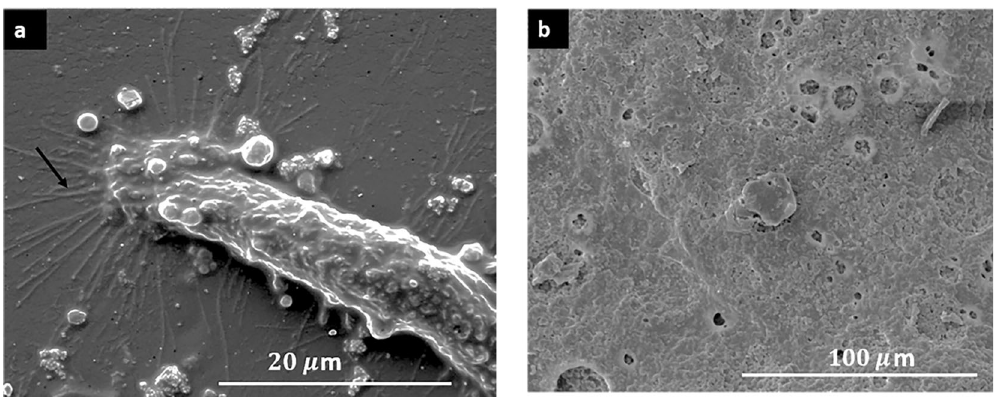
Fig. 9 SEM Images of chitosan/collagen/hydroxyapatite (Cs/Col/HA) membranes seeded with hBFP-MSCs. a Chitosan (Cs). b TC4 (Cs/Col 0.75/ HA 0.15) ( N =